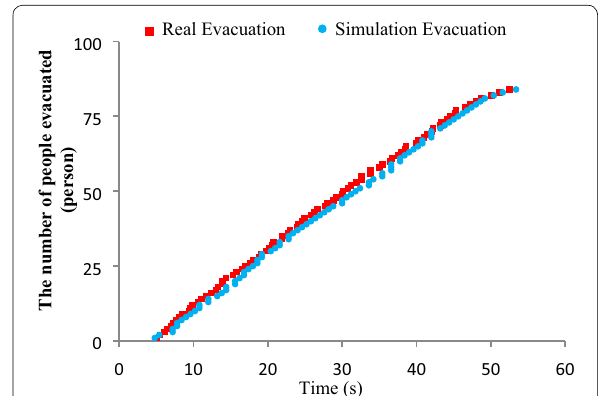
Figure 7 Comparison between real and simulation evacuations